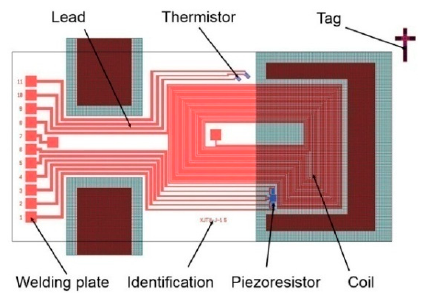
Figure 6. Layout of the rectangular microcantilever chip.